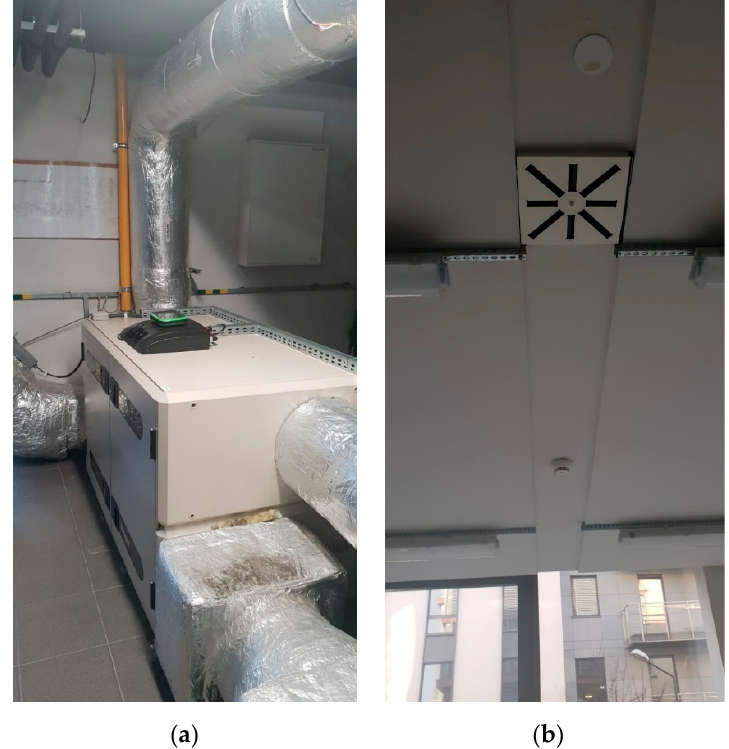
Figure 2. ( a ) View of the A ir H andling U nit (AHU ) with a recuperator with 90% efficiency. ( b )